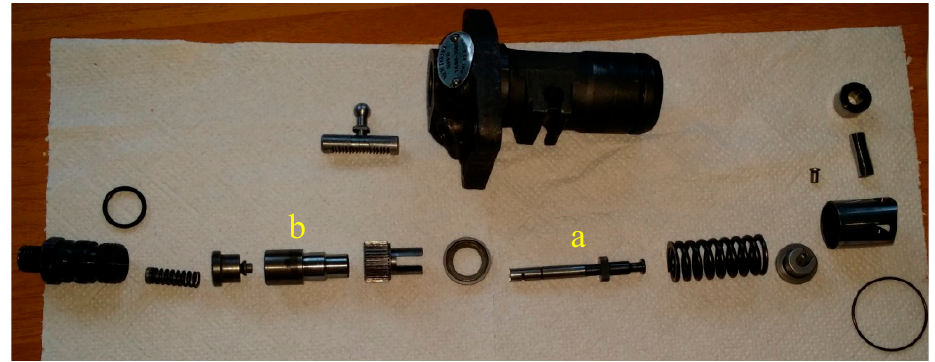
Figure 5. Exploded view of New Diesel pump. ( a ) plunger; ( b ) barrel.